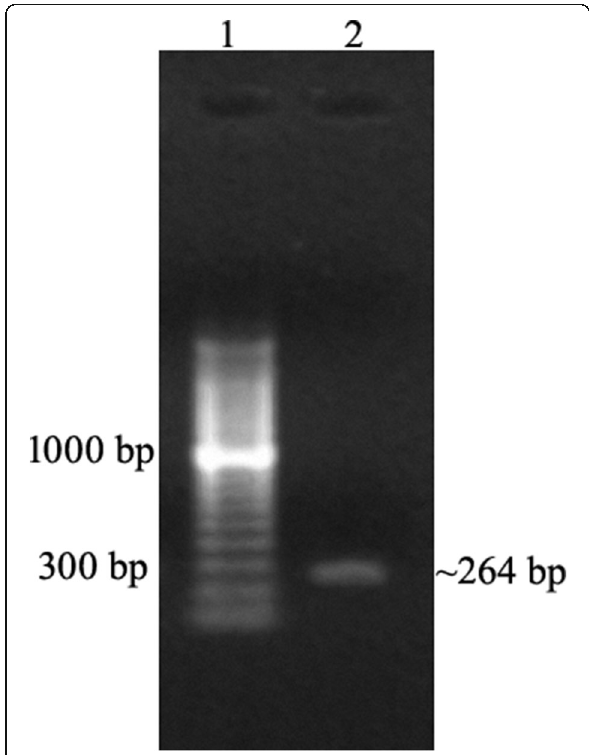
Fig. 8 EhAPC11 cDNA amplicon separated by 1% agarose gel electrophoresis. Lane 1, 100 bp ladder ; Lane 2, PCR product of EhAPC11. The ~ 264-bp band represents EhAPC11 cDNA